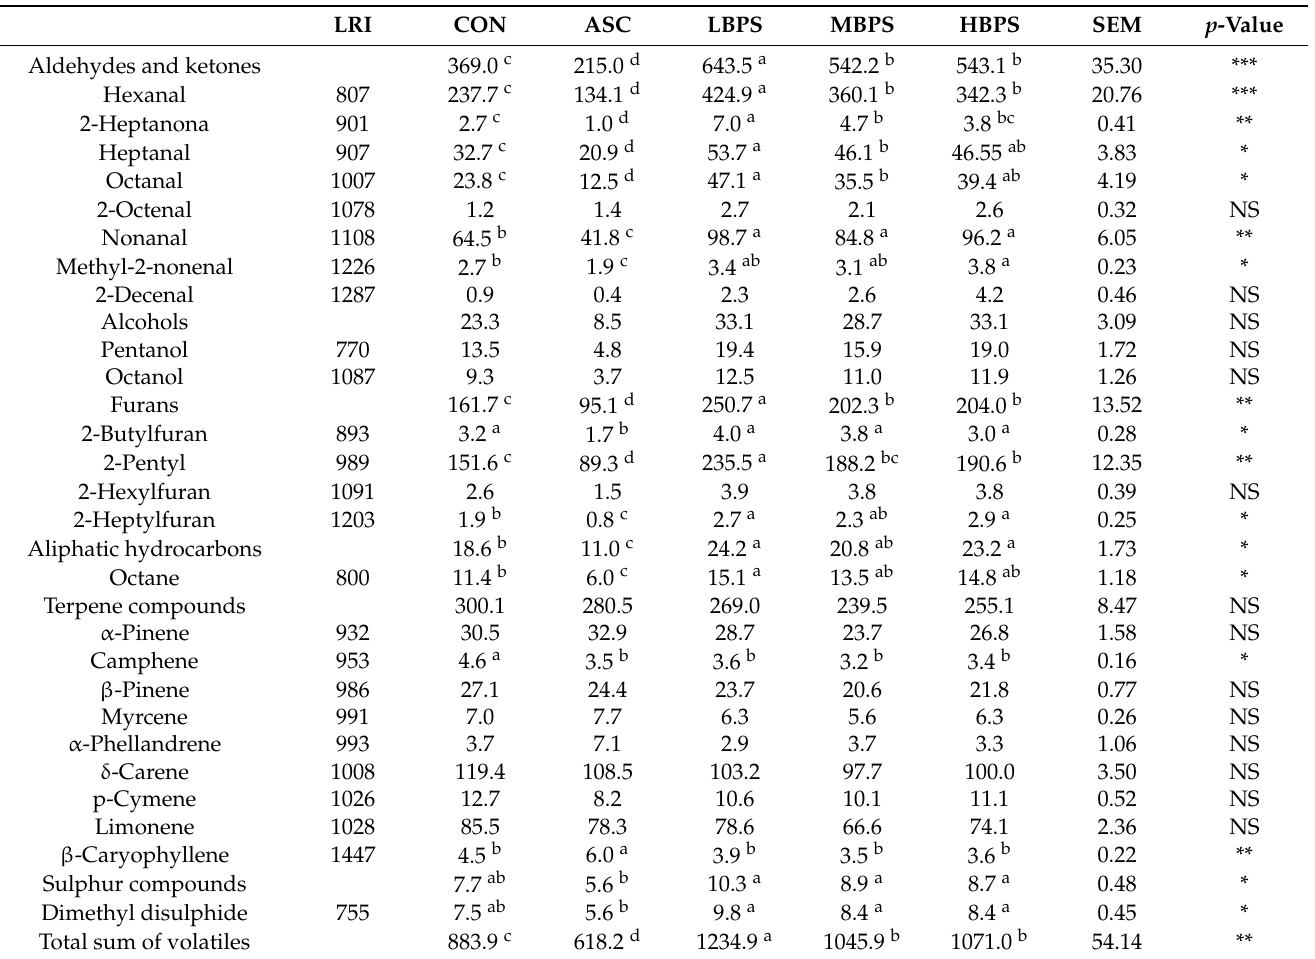
Table 5. Major & and volatile compounds (ng equivalent of hexanal per mL of headspace) in the headspace of cooked pork patties as a function of the type and amount of antioxidant used ( n =